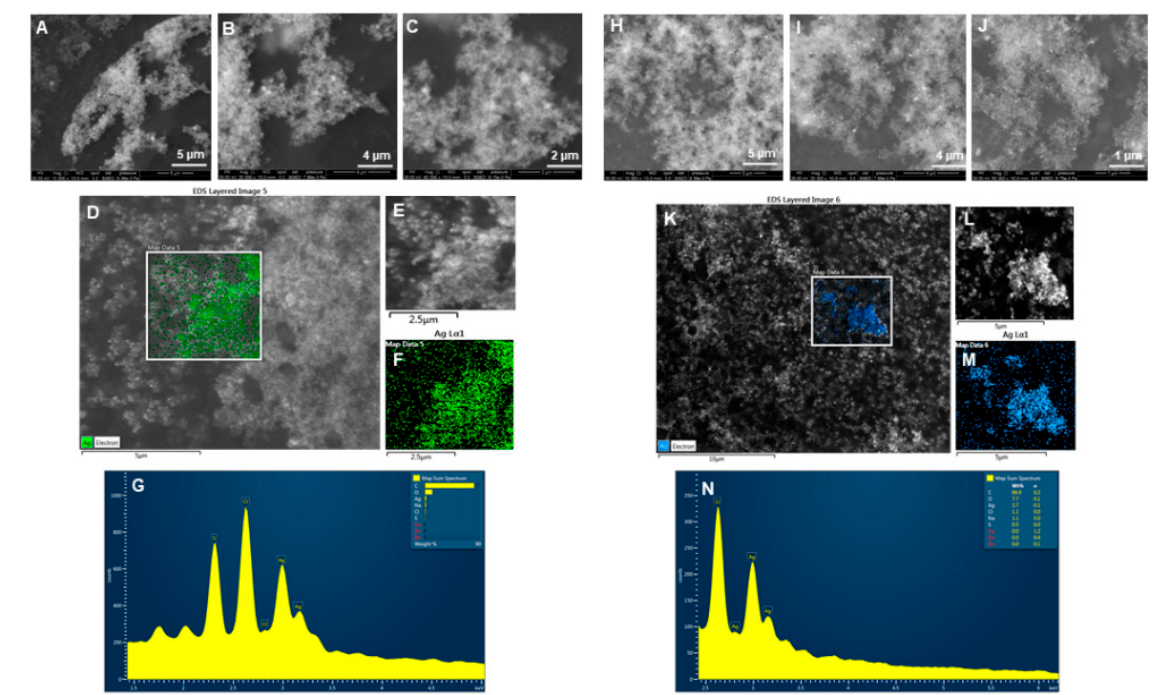
Figure 4. SEM, elemental mapping, and EDX analysis of P-AgNPs and E-AgNPs. For P-AgNPs, ( A – C ) SEM images of nanoparticles at different scales, ( D – F ) Elemental mapping showing scanned image of NPs with silver element distribution (green), ( G ) EDX spectrum of the elemental mapped region showing sharp peak for silver element. For E-AgNPs, ( H – J ) SEM images of nanoparticles at different scales, ( K – M ) Elemental mapping showing scanned image of NPs with silver element distribution (blue), ( N ) EDX spectrum of the elemental mapped region showing sharp peak for silver element.